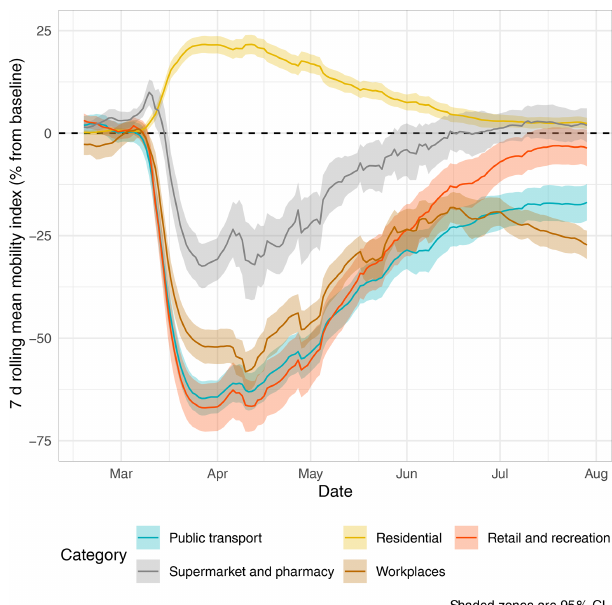
Figure 1. European mobility changes based on Google’s mobil- ity indices between February and July 2020 (©Google, 2020). The metrics display movement trends based on a